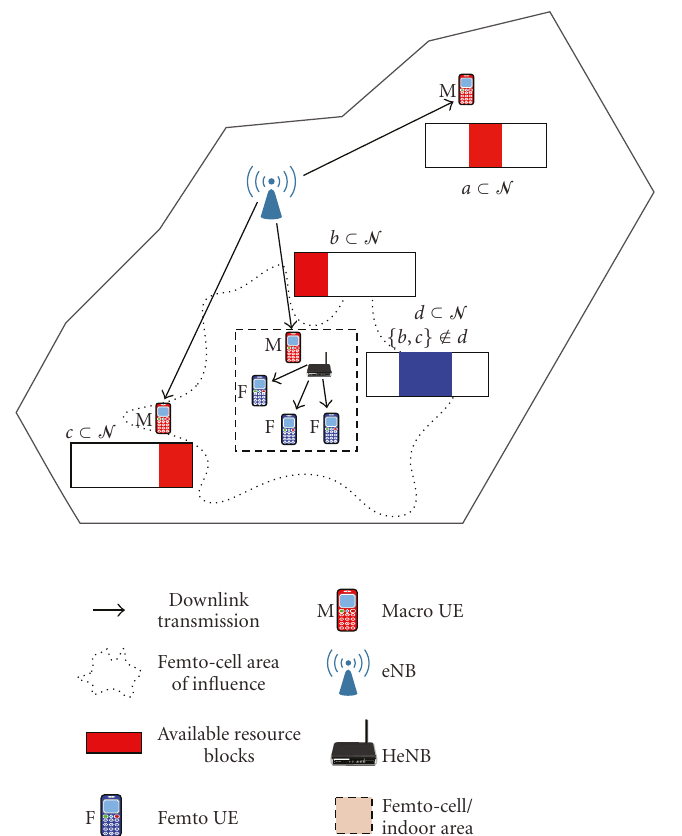
Figure 1: Resource partitioning in the vicinity of a femto-cell. The femto-cell is forbidden from using downlink resources allocated to nearby macro UEs, that is, b and c , but may continue using the set of resources a .